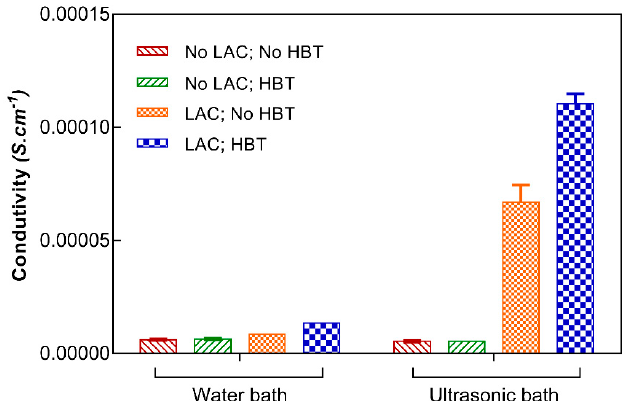
Figure 6. Conductivity of cotton fabrics after coating with polyaniline.